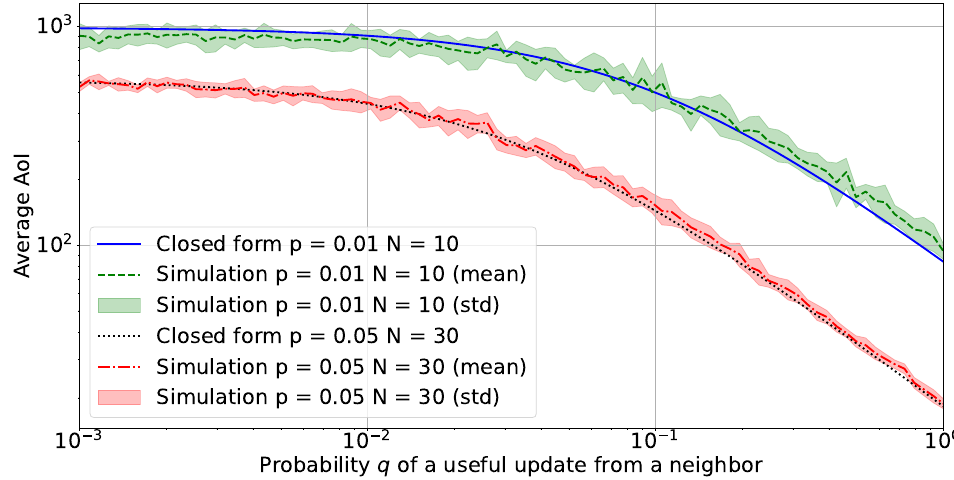
Figure 5. Average AoI with a variable probability of useful updates q from a neighbor. Simulation and theoretical results are